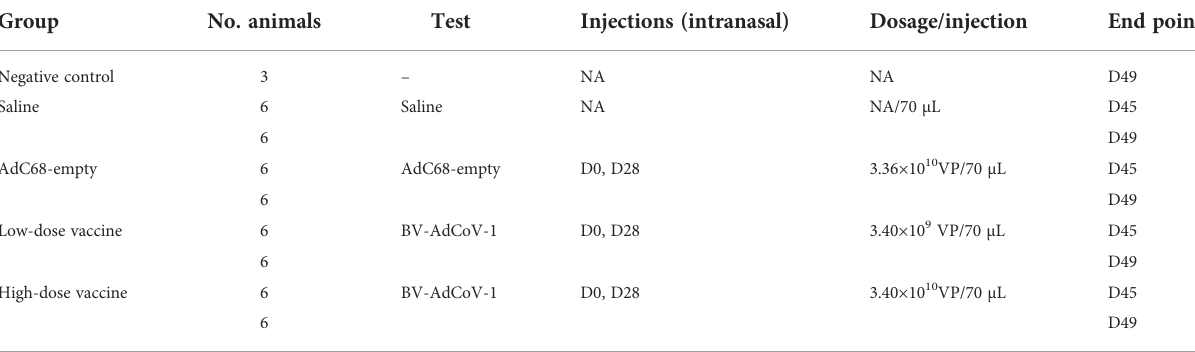
TABLE 1 Grouping of golden Syrian hamsters and vaccine dose. Group